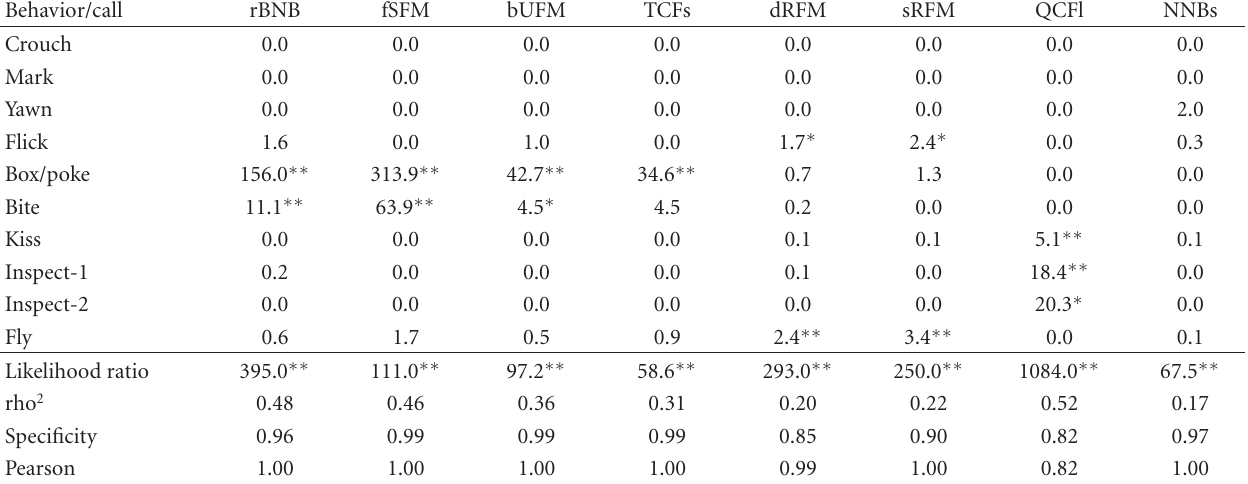
Table 1: A prediction success table generated from logistic regression of vocal activity against behavior (reproduced with permission from Cambridge University Press [26]). Numbers in the body of the table provide the classificatory power of the model and show how observations from each level of the dependent variable (call types) are allocated to predicted outcomes. The results provide an indication of the strong association of the di ff erent call types (columns) with specific behaviors (rows). The likelihood ratios are highly significant, and the specificity index ranges from 0.82 to